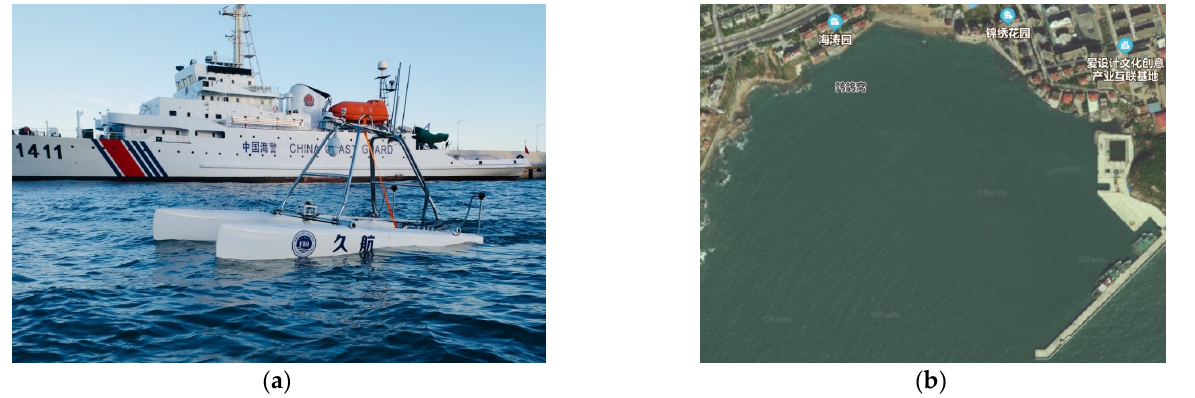
Figure 11. Sea experiments at Qingdao in 2018. ( a ) The ‘Jiuhang’ USV during the sea experiments; ( b ) location of the sea experiments.